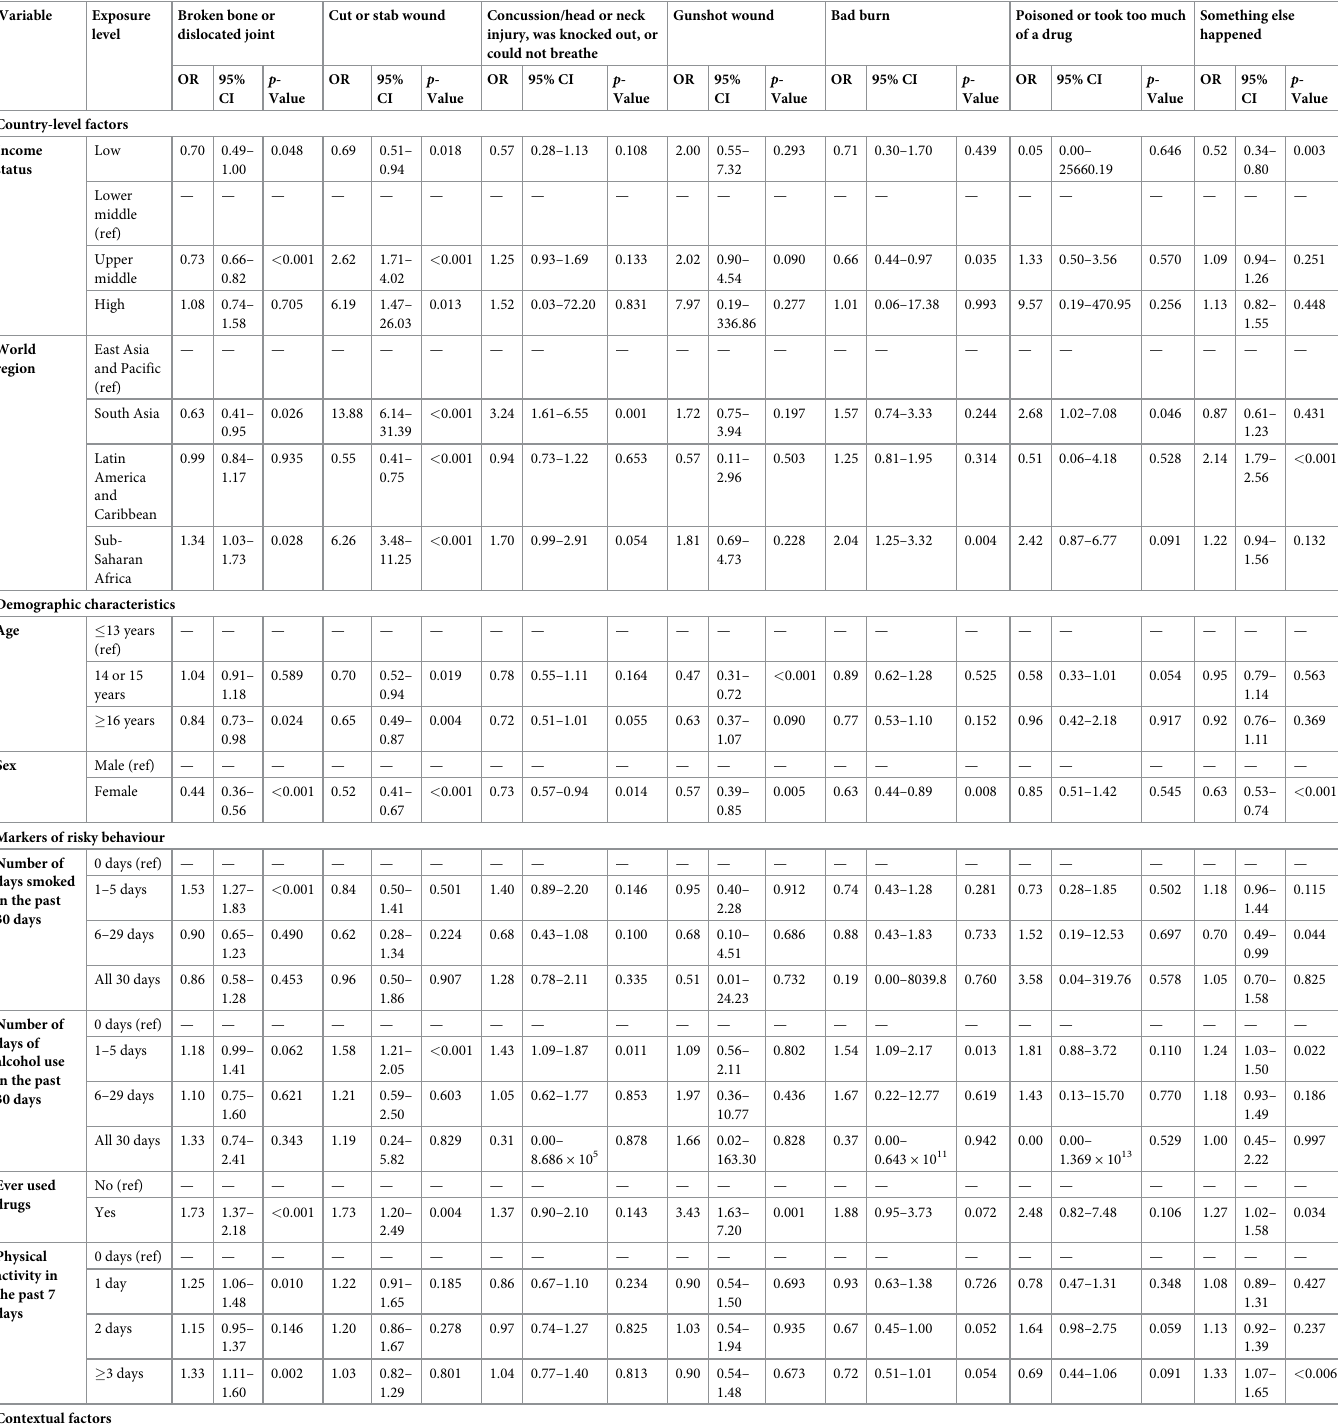
Table 5. Multivariable associations between serious injury type, country-level factors, and individual-level factors of risky behaviour, contextual factors, protective factors, and indicators of poor mental health. Variable Exposure Brokenboneor level